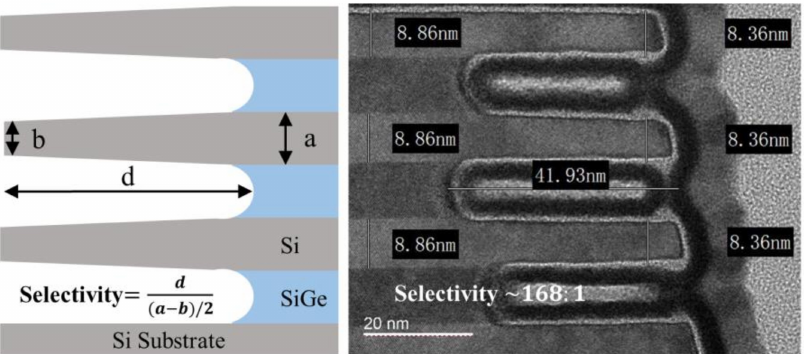
Figure 4. SiGe versus Si etching selectivity of multi-step etching with the application of oxida- tion